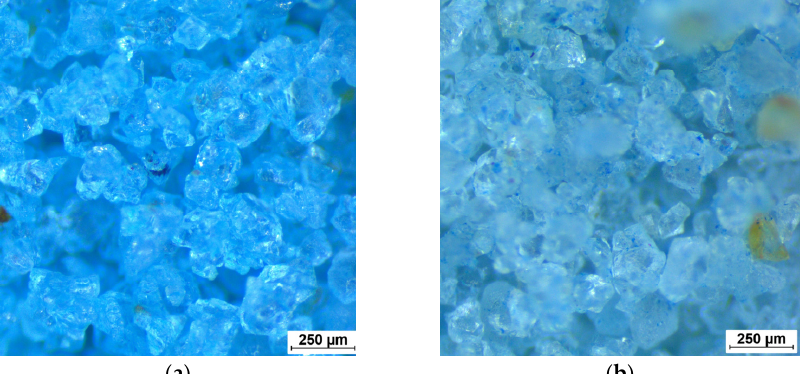
Figure 7. Micrographs of the kinetic sand. ( a ) Original sample; ( b ) Boiled sample. Size of sand grains observed during microscopy matches the output of sieve test.